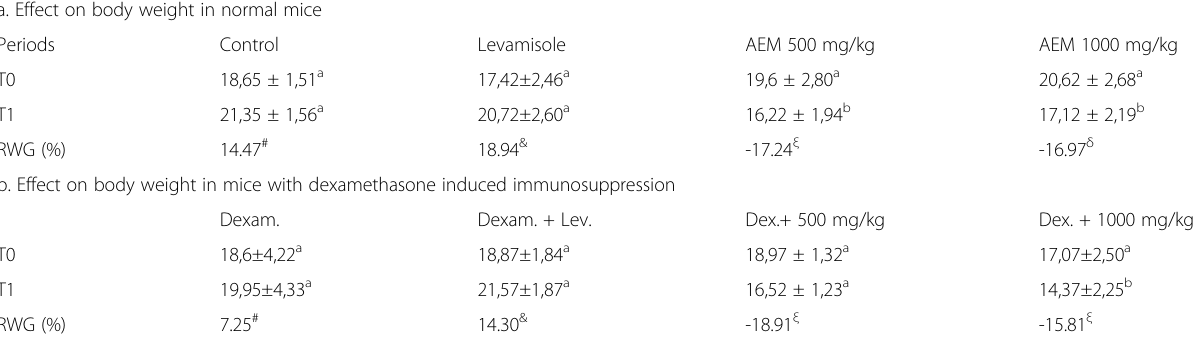
Table 5 Effect of extract and levamisole on body weight in